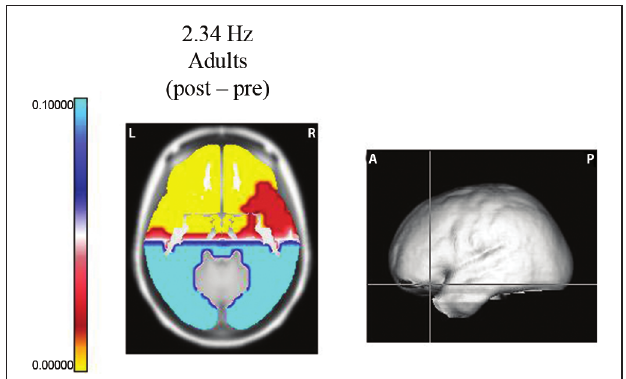
FIGURE 1 | Probability map for frequency 2.34 Hz. Sternberg task. Longitudinal slice of the region where the maximum difference was observed between the post segment (when the subject was maintaining the five digits in memory) and the pre EEG segments (before the presentation of the data set). At the right, the levels of the slice on the average brain are shown. Significant increases (yellow color) were observed in the left orbitofrontal